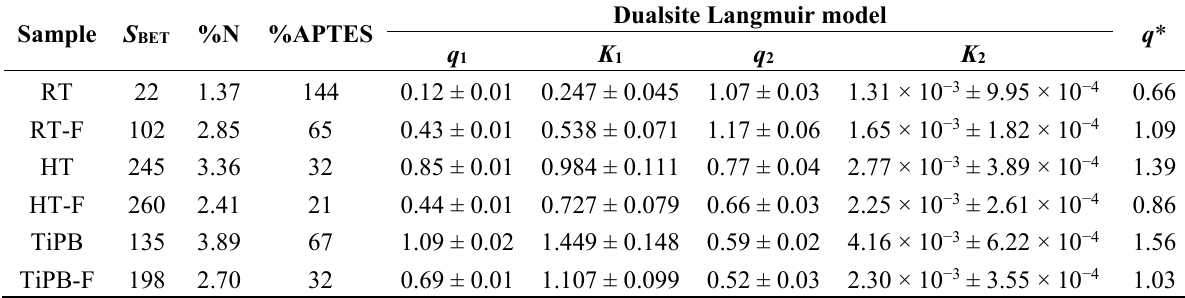
Table 4. Parameters from fit to Dualsite Langmuir model for amine grafting samples (20%